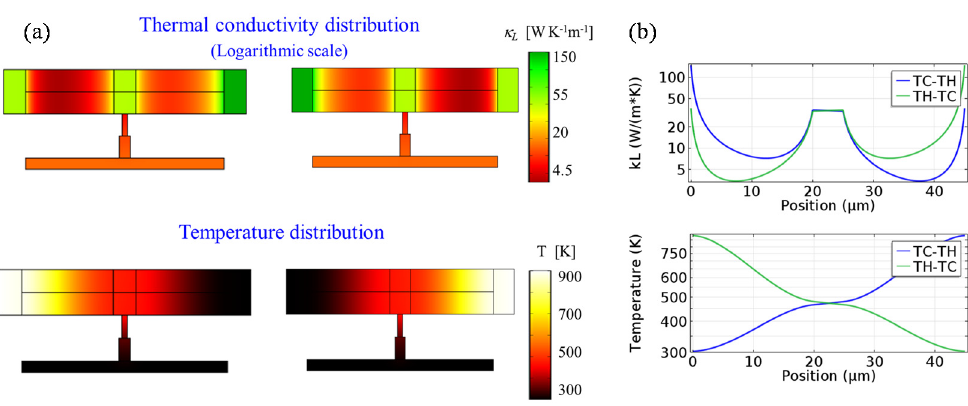
Figure 5. ( a ) Thermal conductivity (top) and temperature (bottom) distribution (color scale) for the designed AND gate. One end is held at high temperature (high input), while the other end is held at low temperature (low input). The center region is connected to a heat sink via a low thermal conductivity connector. The thermal conductivity at each position along the slab is controlled by grading the alloy. The ends and center at which the temperature is measured have a high thermal conductivity. ( b ) Associated plots indicating the exact thermal conductivity and temperature distributions across the slab for the forward and reverse configurations. The exact position on the axis is arbitrary since we consider normalized position. Table 1. AND gate based on thermal rectifier and resulting truth table. The temperature is fixed at a high temperature of 900 K (high input, 1) or a low temperature of 300 K (low input, 0). The output, ε , is calculated, demonstrating that a high output only occurs when both of the inputs are high. Other logic gates can be created using a similar strategy to that employed here. T A [K]